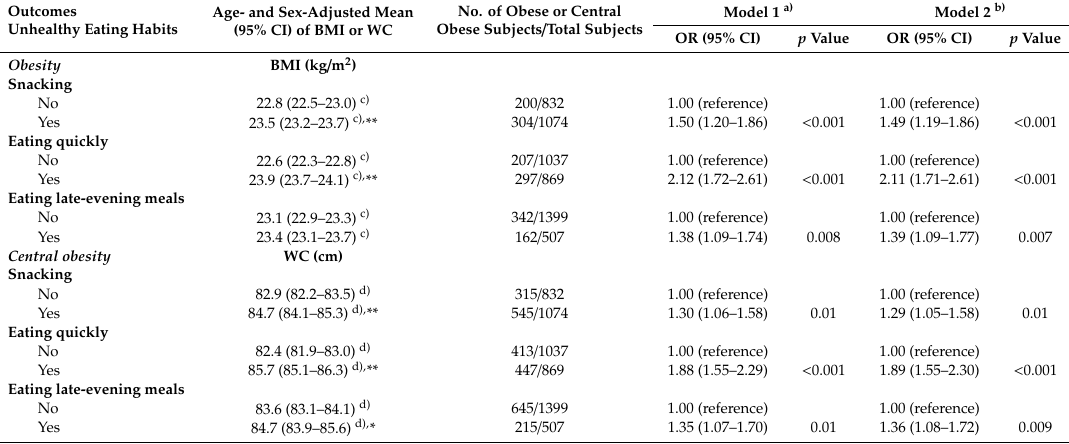
Table 2. Multivariable-adjusted likelihood of the presence of obesity and central obesity according to the status of each unhealthy eating habit.